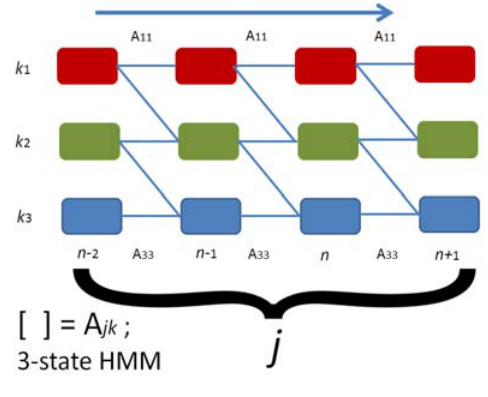
Figure 23. It is a 3-state HMM array by A